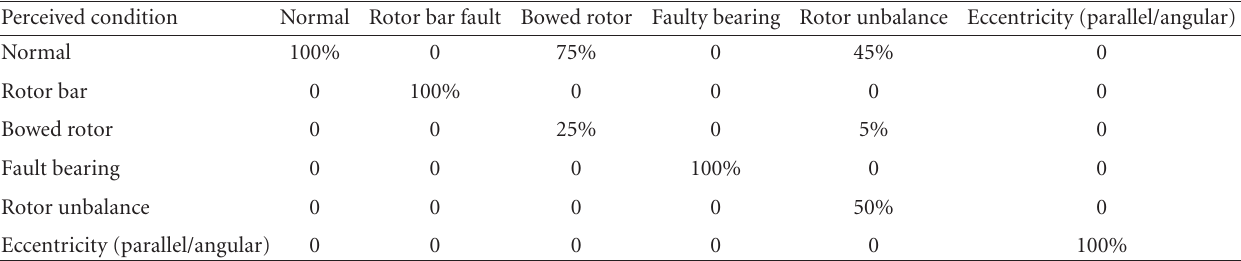
Table 8: Success rate under full-load condition using only time-domain features ( ρ = 0 .